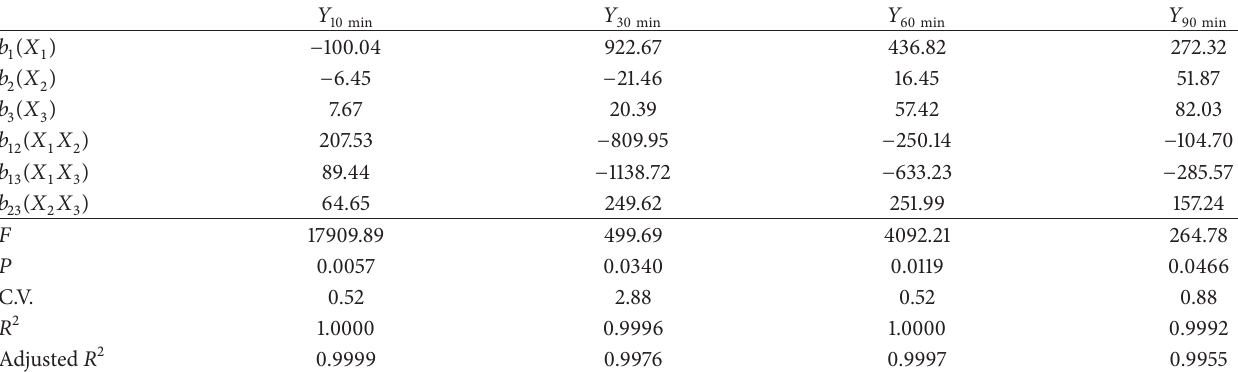
Table 3: Optimal regression equation for each response variable.